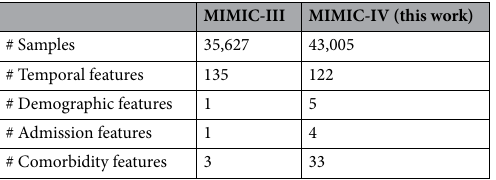
Table 1. Differences between preprocessed MIMIC-III in 1 and preprocessed